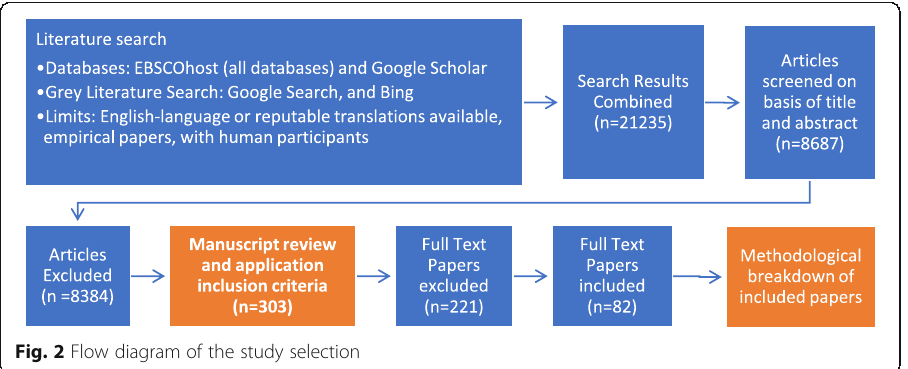
Fig. 2 Flow diagram of the study selection